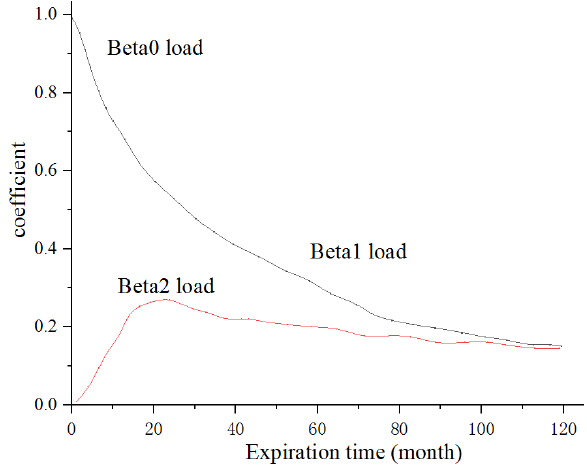
Fig. 1 Parameter changes of Nelson-Siegel model.